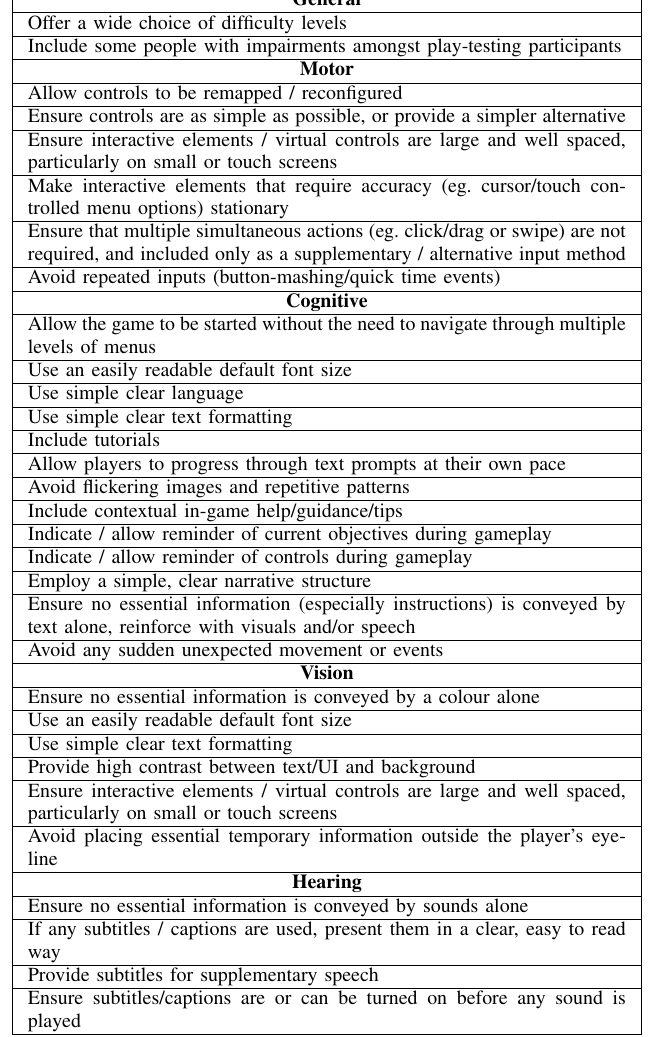
TABLE III G AME A CCESSIBILITY G UIDELINES (GAG) USED General Offer a wide choice of difficulty